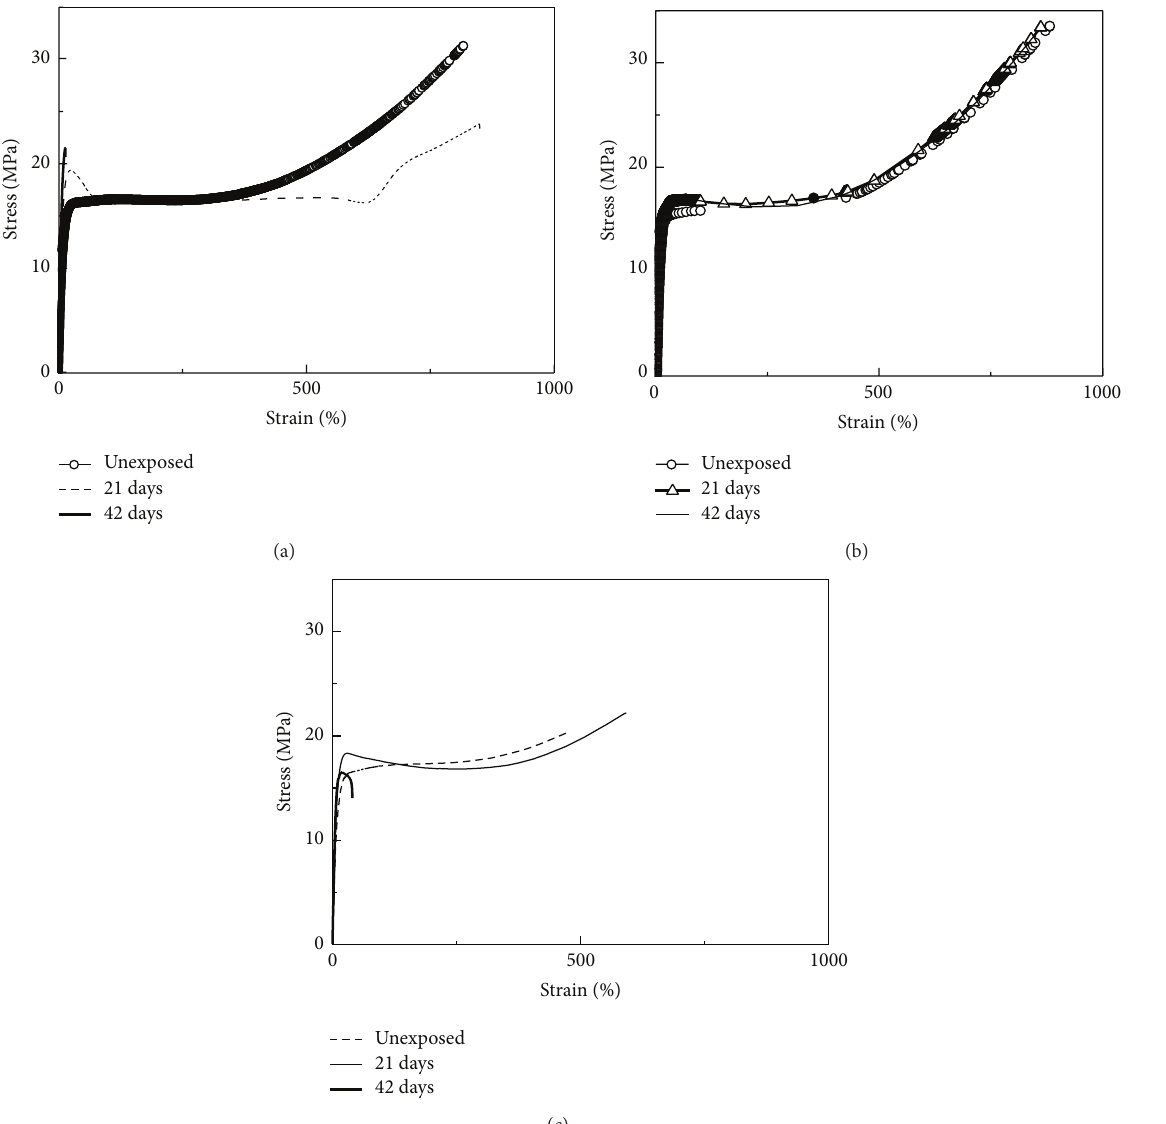
Figure 7: Stress strain curves in different times of UV exposure from (a) neat UHMWPE, (b) UHMWPE with beet extract, and (c) UHMWPE with annatto